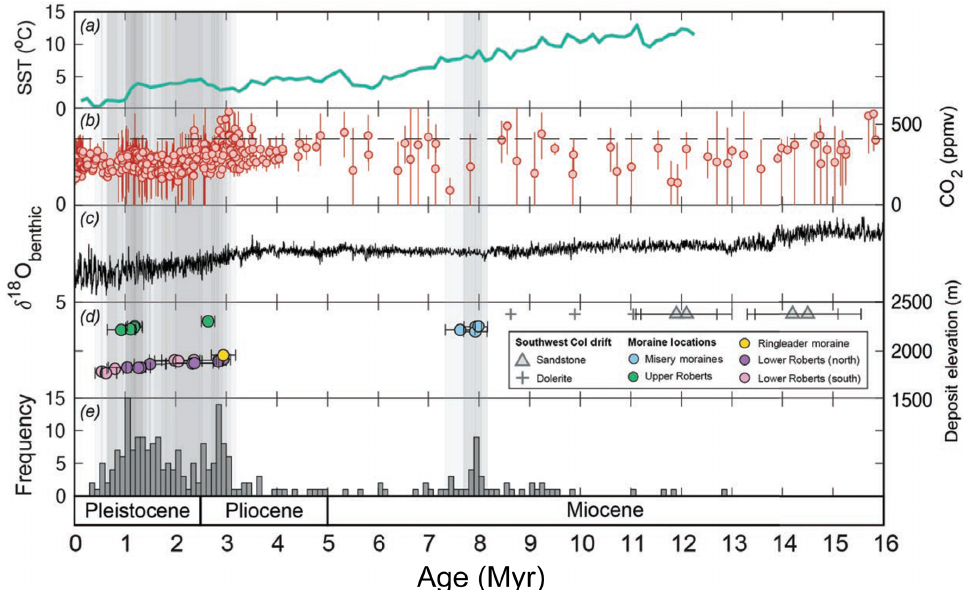
Figure 14. Comparison between Roberts Massif glacial chronology and relevant climate records. (a) Southern Hemisphere alkenone-derived temperature stack (Herbert et al., 2016). (b) Boron-isotope-, paleosol-, and stomata-derived CO2 records (Beerling et al., 2009; Breecker and Retallack, 2014; Da et al., 2019; Dyez et al., 2018; Ji et al., 2018; Sosdian et al., 2018; Wang et al., 2015; Zhang et al., 2013). (c) Benthic oxygen isotope stack (De Vleeschouwer et al., 2017). (d) Moraine age and uncertainty at Roberts Massif, plotted against deposit elevation. Note that deposition of the Misery moraines required ice to be > 300m thicker than today, which is not reflected in the moraine elevation. The age of the Southwest Col sandstones account for erosion, as described in Sect. 3.2.2. (e) Histogram of all apparent exposure ages at Roberts Massif, including outliers. Vertical gray bars denote moraine ages, including uncertainty. Darker gray color shows a higher frequency of